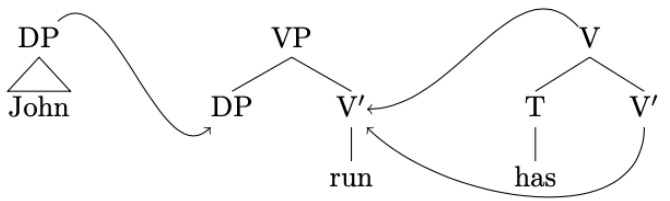
Figure 6. Elementary trees following